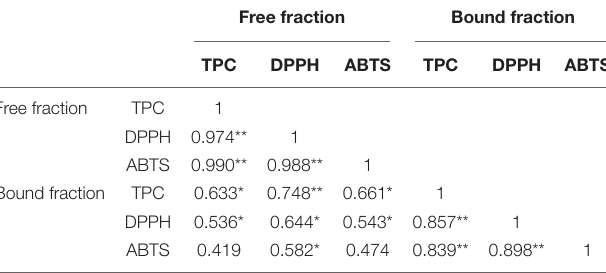
**indicate significant at p ≤ 0.01. *indicate significant at p ≤